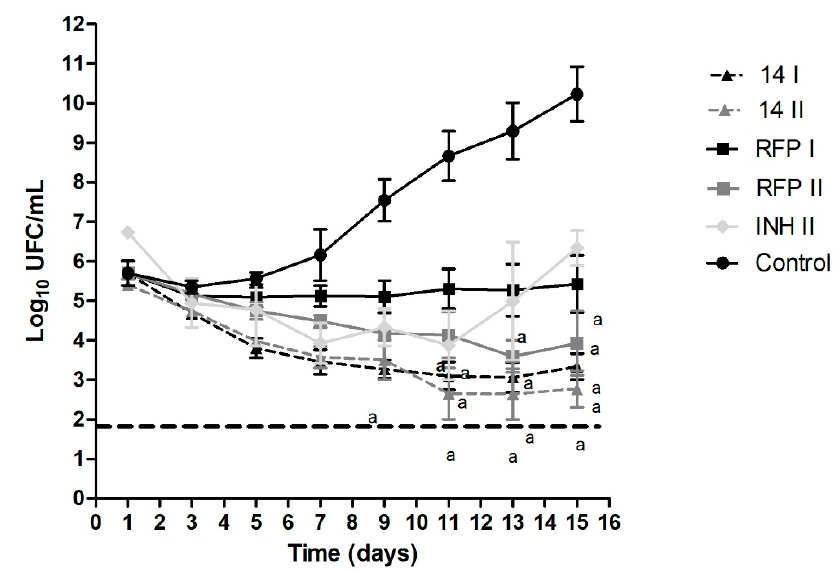
Figure 3. Time–kill curve of hydrazone 14 at 1× (14 I) and 2× (14 II) MIC and controls: rifampicin (RFP) 1× and 2× MIC, isoniazid (INH) 2× MIC and negative control (control). Dotted line represents a reduction of 3 log 10 CFU/mL. Statistical analysis was performed using Prism 5.0. The data were analyzed using one-way analysis of variance, followed by Newman–Keels post-hoc test. The results are presented as the mean ± standard deviation from three independent experiments; a: p < 0.05 compared to control group.